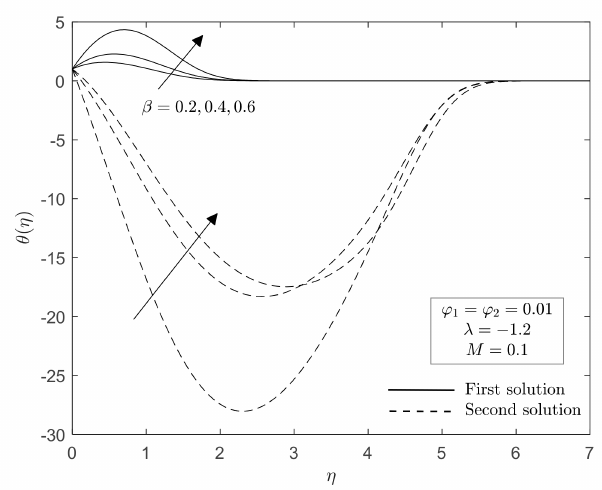
Figure 6. Temperature profile θ ( η ) for selected values of heat source β (Shrinking sheet case) when M =